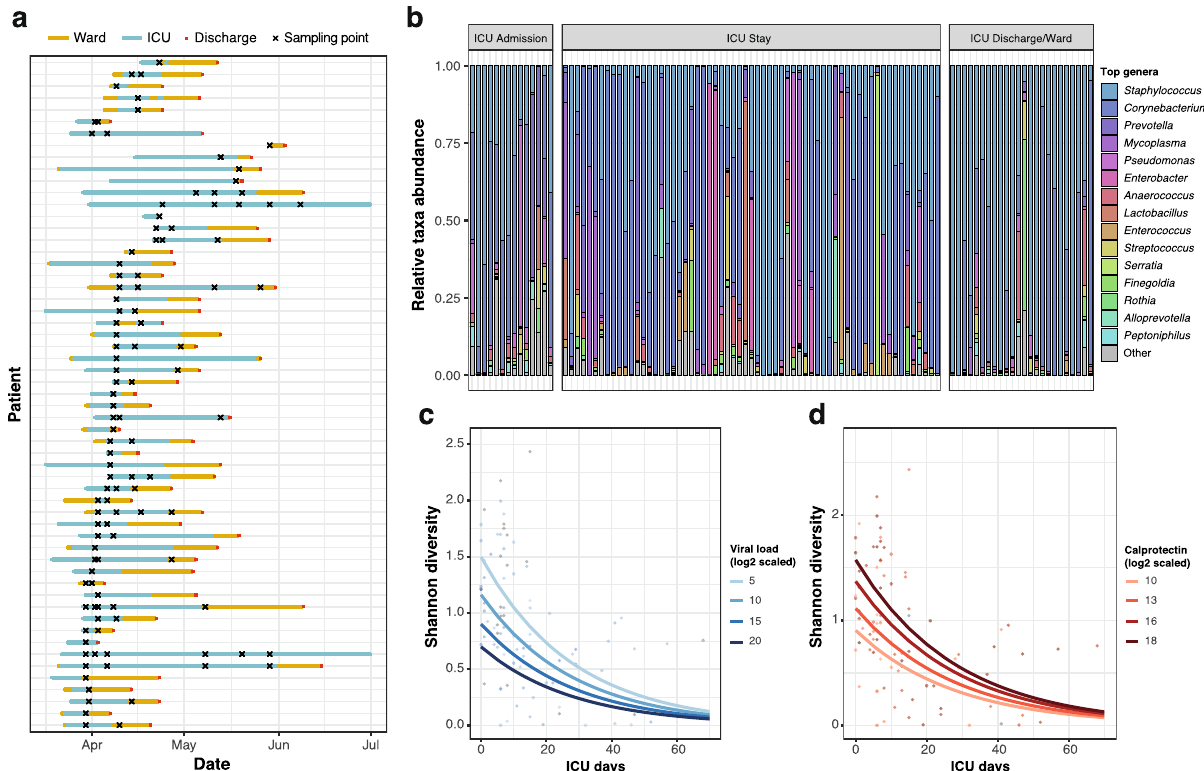
Fig. 1 Sample overview and alpha diversity. a Longitudinal sampling of patients ( n = 58 patients). Each line represents one patient. Yellow lines span the days spent in ward, while blue lines span the days spent in ICU. Red points mark hospital discharge dates. Crosses indicate the timepoints where swab samples were obtained for microbiome analyses. b Top 15 most abundant genera in this cohort. Samples with >10,000 reads assigned to microbial taxa at the genus level ( n = 101) were strati fi ed according to the sampling moment: upon admission, throughout the ICU stay or at ICU discharge/during treatment in ward. c Effect of the length of ICU stay and SARS-CoV-2 viral load on upper respiratory tract microbiome diversity ( n = 89, after removal of samples with missing data). The plot shows the model-predicted Shannon index as a function of the days in ICU, for different levels of SARS-CoV-2 viral load (selected within the range of observed data). Con fi dence intervals for the predictions are shown in Supplementary Figure 1c. d Association of the length of ICU stay and calprotectin gene expression levels with upper respiratory tract microbiome diversity ( n = 89, after removal of samples with missing data). The plot shows the model-predicted Shannon index as a function of the days in ICU, for different levels of calprotectin RNA (subunit S100A8) gene expression, selected within the range of observed data. Con fi dence intervals for the predictions are shown in Supplementary Figure 1d. Source data are provided as a Source Data fi